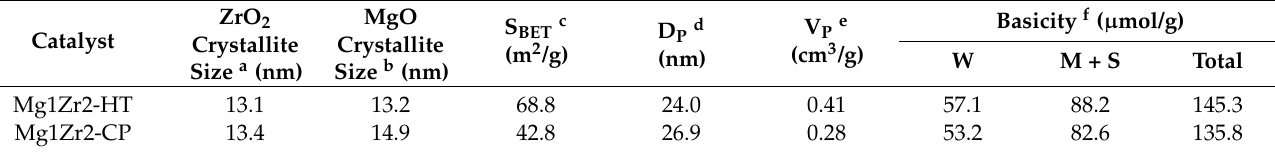
Table 1. Texture properties and surface basicity of Mg1Zr2-HT and